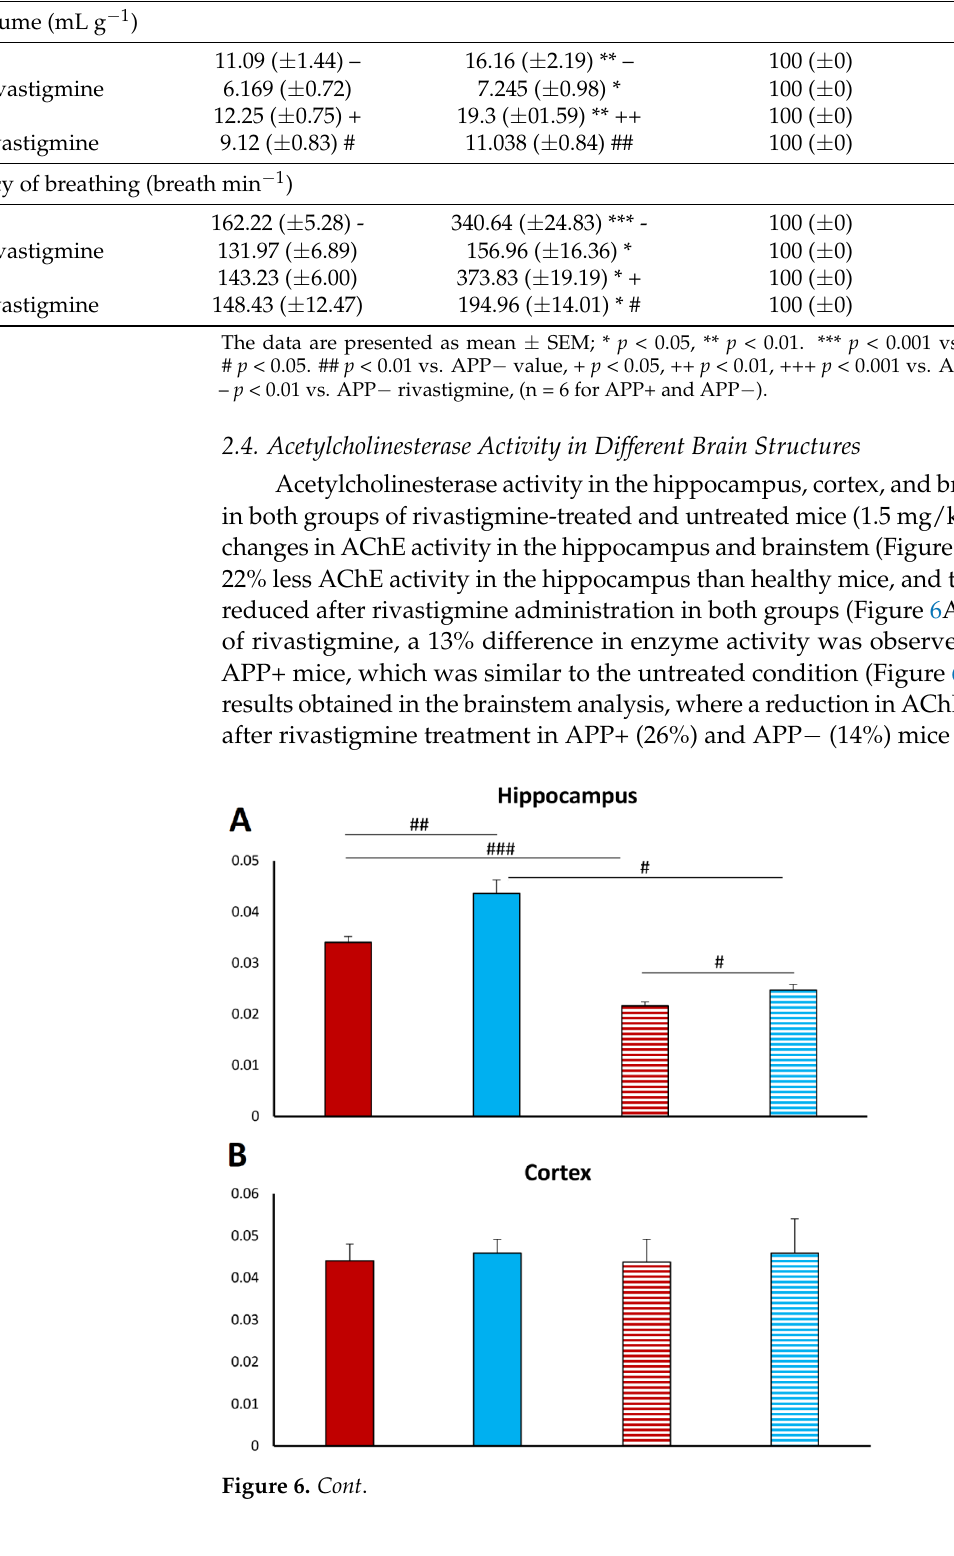
Figure 6. Acetylcholinesterase activity in hippocampus ( A ), cortex ( B ), and brainstem ( C ) in APP+ and APP − mice untreated (solid bars) and treated (striated bars) with rivastigmine. Data are ex- pressed in mU min -1 mg -1 and presented as mean ± SEM. # p < 0.05, ## p < 0.01, ### p < 0.01 (n = 6 per each bar). 3. Discussion Our study is the first in a transgenic model of Alzheimer ’ s disease to address respir- atory responses to the stressful stimuli of hypoxia and hypercapnia. The main finding of our study was a notable increase in the ventilatory response to hypercapnia and no dif- ference in the ventilatory response to hypoxia in APP+ mice, compared with their controls. In contrast, respiratory parameters during air breathing were comparable in both groups. A previous study in a streptozotocin (STZ)-induced model of AD displayed blunted ventilatory response to hypoxia with concomitant astrogliosis in the commissural part of the nucleus tractus solitarii (NTS) [12]. The authors speculated that astrogliosis of the pri- mary site for afferent input from hypoxia-sensing carotid bodies (CB) [17] could contrib- ute to inflammation and reactive oxygen species (ROS) formation and to impaired NTS